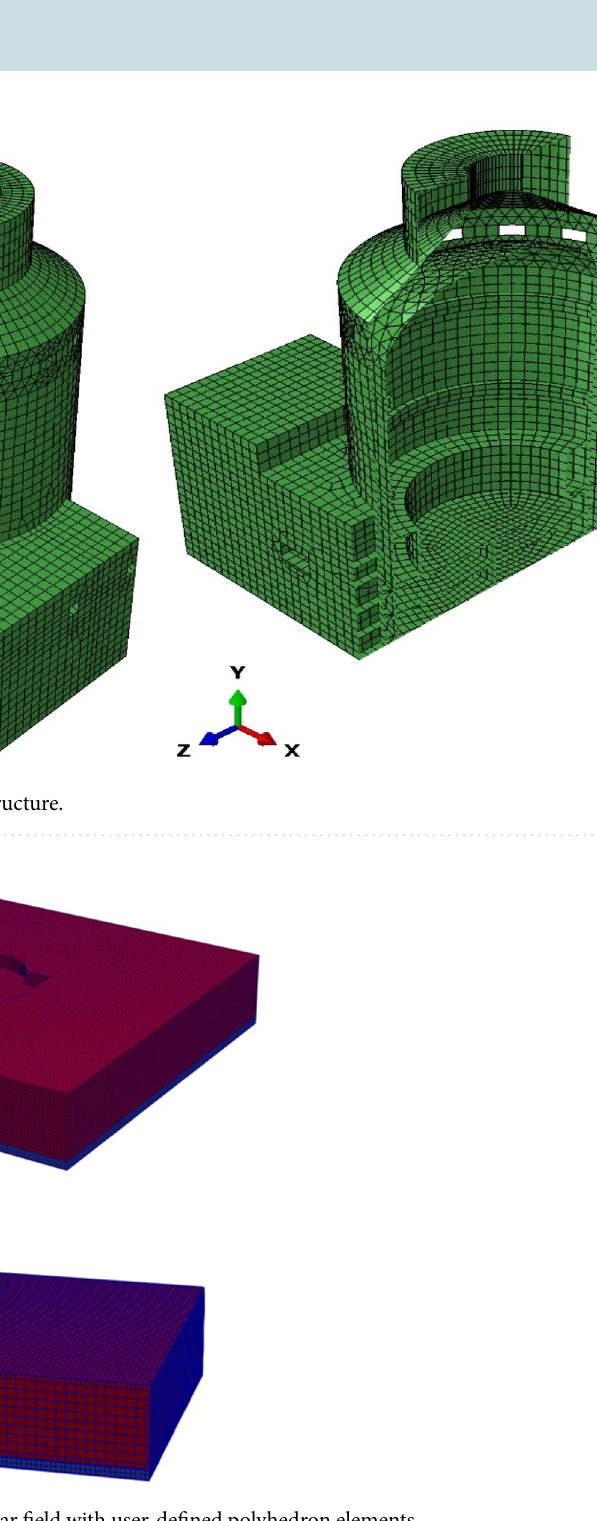
Figure 22. FEM model of the NPP near field with user-defined polyhedron